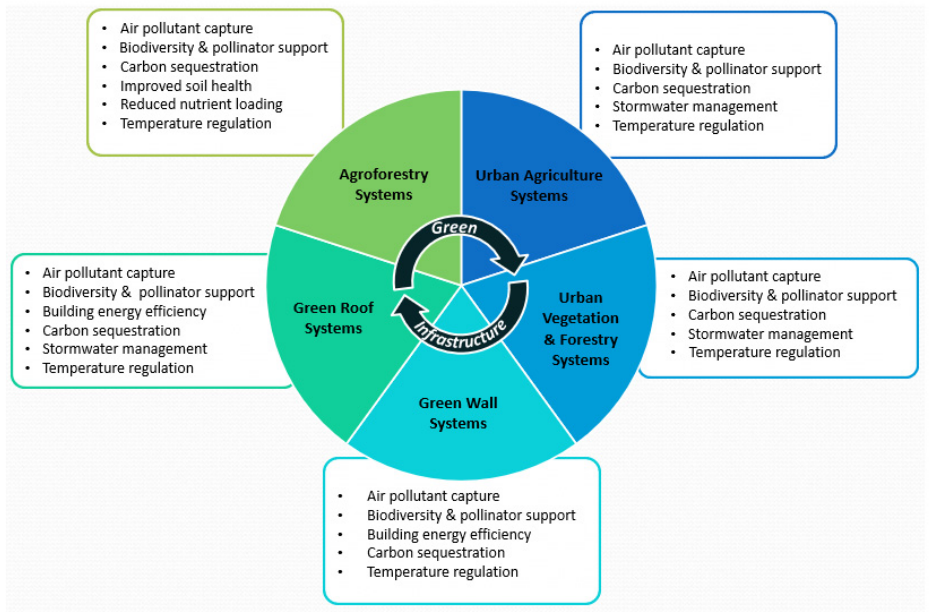
Figure 1. Green infrastructure form and function [8–10,14,39,60].